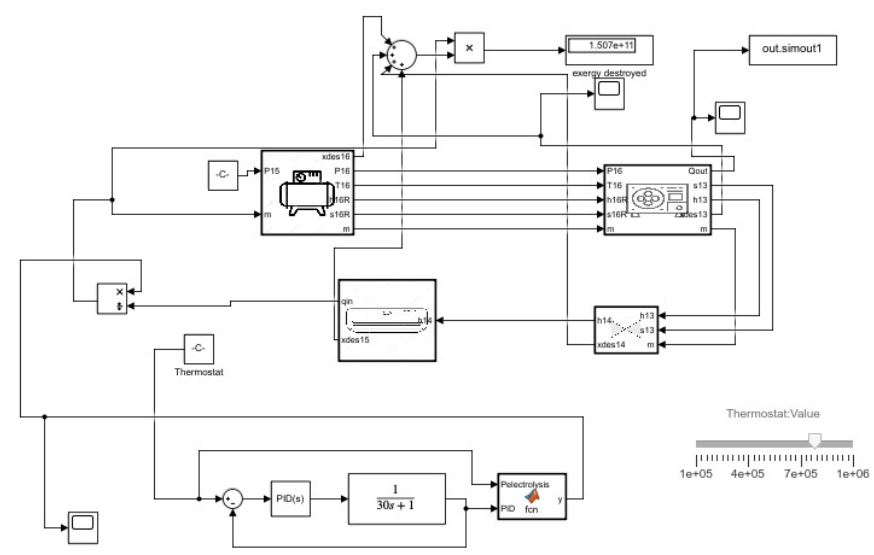
Figure 2. Airconditioning cycle Simulink model.